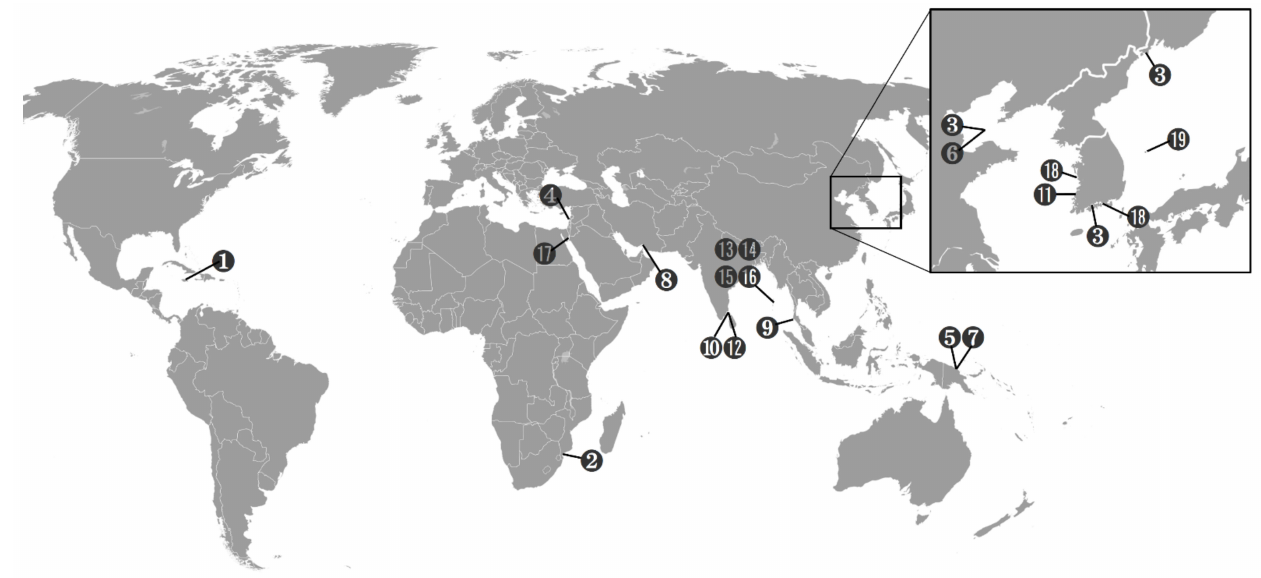
Figure 23. Distribution of Scottolana species. (1) S. antillensis ; (2) S. brevifurca ; (3) S. bulbifera ; (4) S. bulbosa ; (5) S. dissimilis ; (6) S. geei ; (7) S. glabra ; (8) S. gomezi ; (9) S. huysi ; (10) S. inopinata ; (11) S. jasani ; (12) S. longipes ; (13) S. oleosa ; (14) S. rostrata ; (15) S. scotti ; (16) S. tumidiseta ; (17) S. uxoris